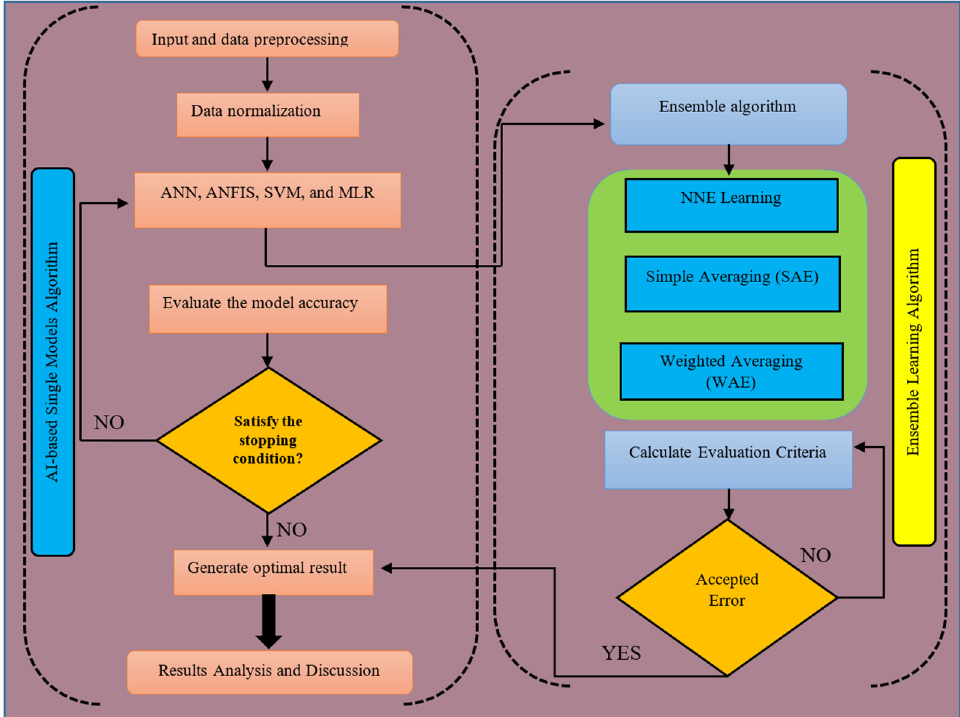
Figure 3. Flowchart of the ANN, SVM, ANFIS, MLR, and ensemble learning-based model-building process.